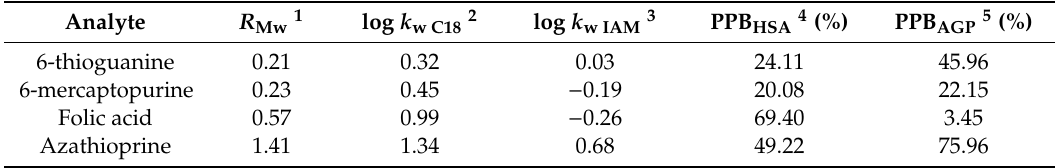
Table 1. Experimental parameters obtained by chromatographic